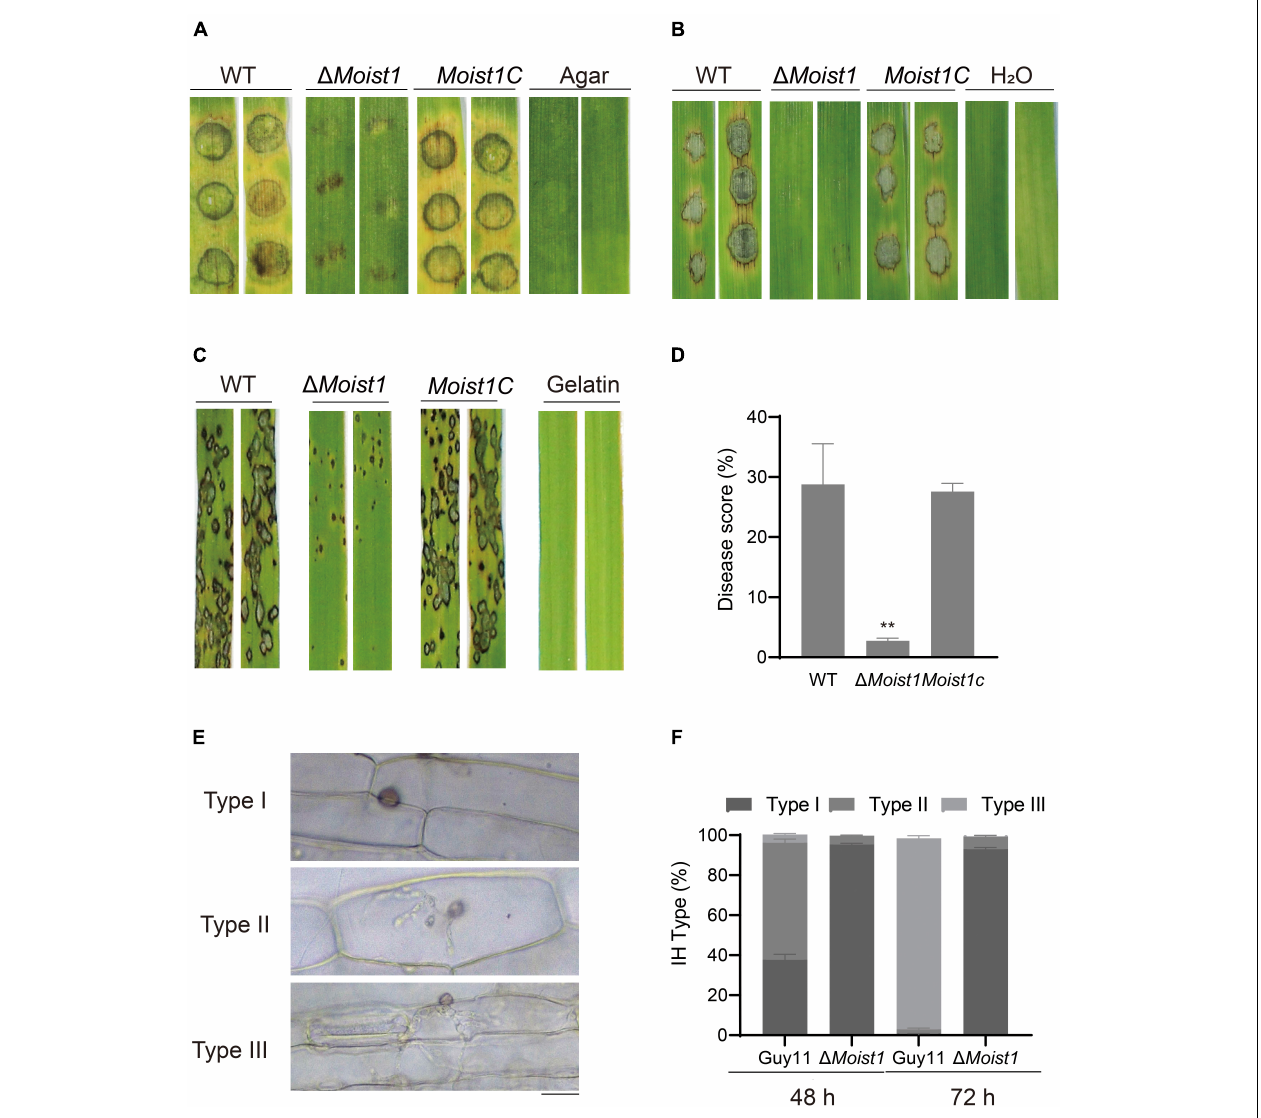
FIGURE 2 | MoIst1 is required for plant penetration and pathogenicity in M. oryzae . (A) Pathogenicity of mycelial plugs on barley leaves. (B) Pathogenicity of spore suspensions (5 × 10 4 ml − 1 ) on barley leaves. (C) Pathogenicity of spore suspensions (5 × 10 4 ml − 1 ) on rice leaves. (D) Five-centimeter-long leaves of each rice leaf were taken for statistics of the number of disease spots. The standard deviation is represented by error bars. Tukey’s test was used to test significant differences: ** P < 0.01. (E) The IHs of WT and (cid:49) Moist1 were divided into three types. Bar = 20 µ m. (F) The three types of IHs were quantified and statistically significant at 48 and 72 hpi. The standard deviation is represented by error bars. Tukey’s test was used to test significant differences: ** P <